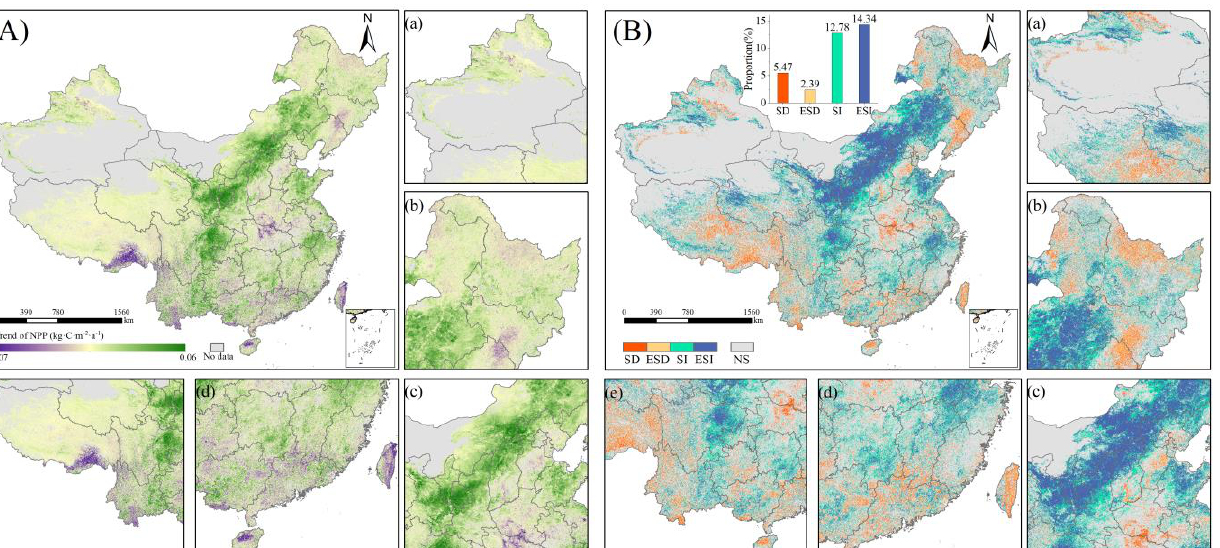
Figure 3. Spatial and stable patterns of NPP. (a)−(e) represent the detailed information for the tively.